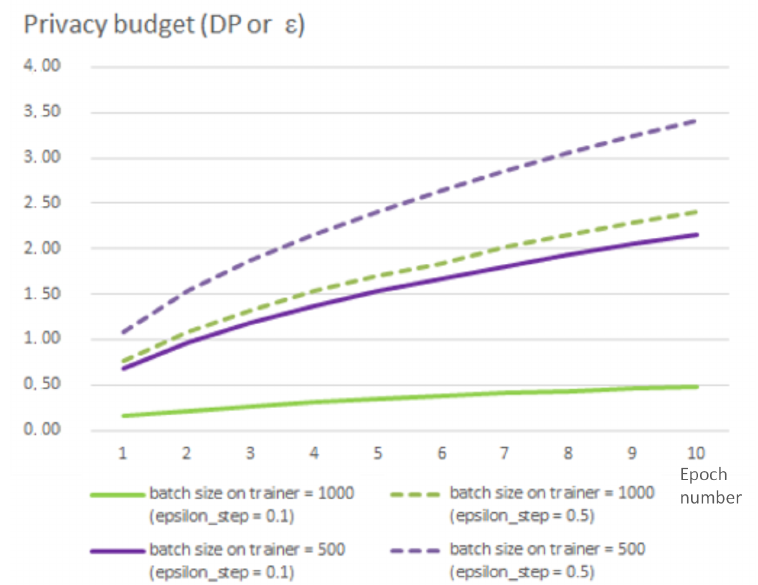
Figure 8. Privacy budget depending on batch size and epoch number.